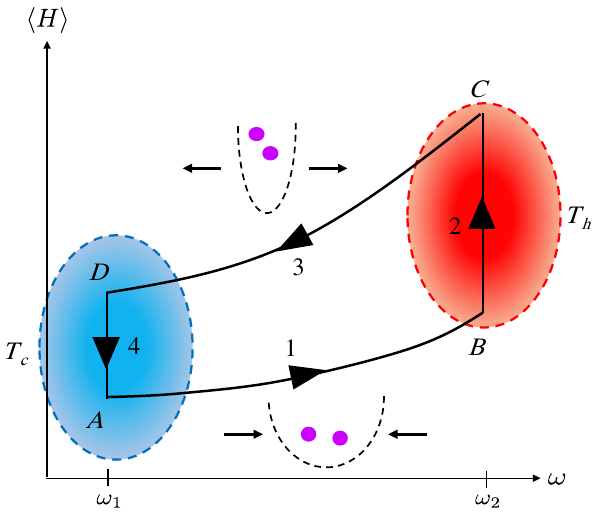
FIG. 7. Energy-frequency diagram of a quantum Otto cycle for a harmonic trapping potential with a working medium of two